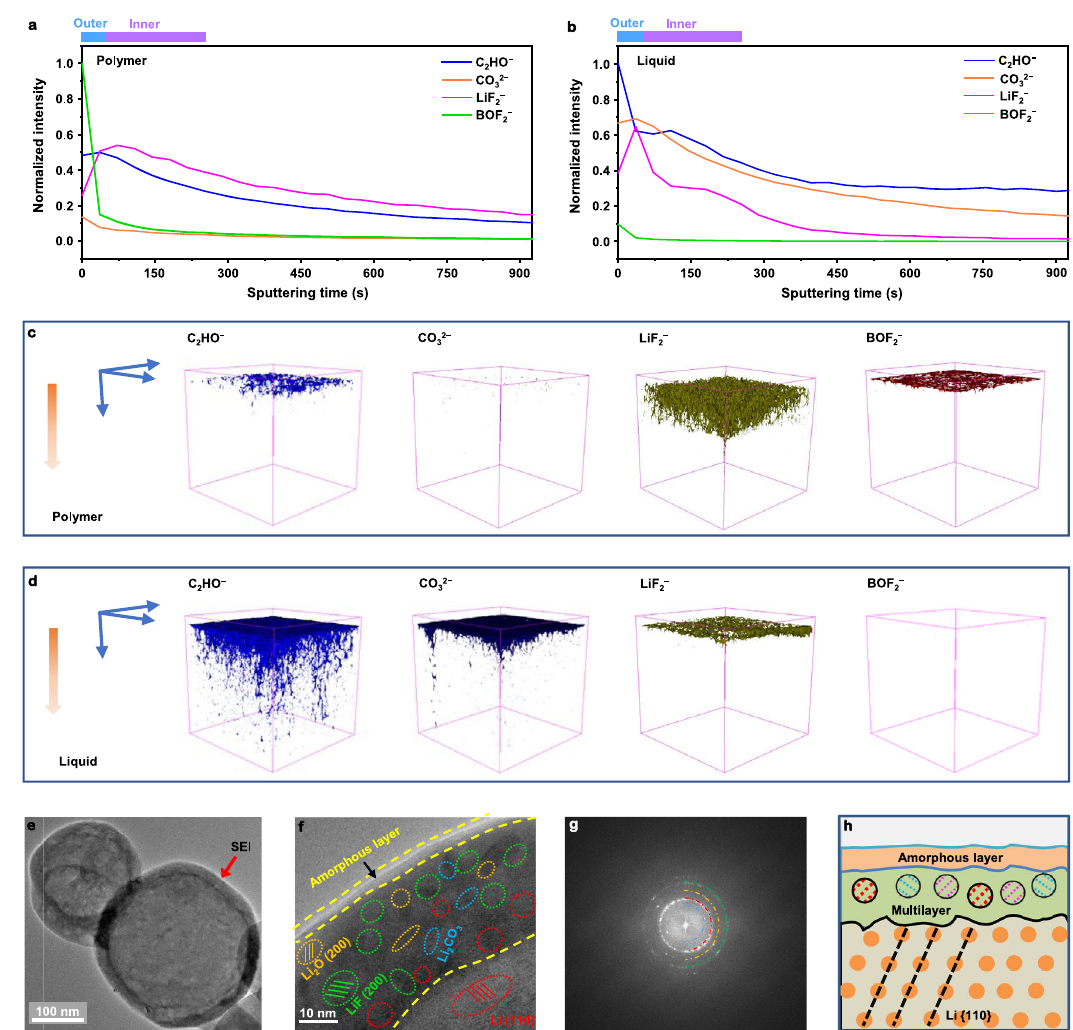
Fig. 5 | Physicochemical characterizations of the Li metal electrode SEI via exsitupostmortemmeasurements.a , b Depthpro fi les of the LiSEIsinLi||Licoin cellswiththedesignedpolymerelectrolyte( a ),andtheliquidelectrolyte( b ). c , d 3D renders of the Li SEIs in Li||Li coin cells with the polymer electrolyte ( c ), and the liquid electrolyte ( d ). The characterized LMAs were collected from Li||Li coin cells after100cyclesat − 20°Cand 0.2mAcm − 2 . e , f Cryo-TEMimagesofdepositedLiin